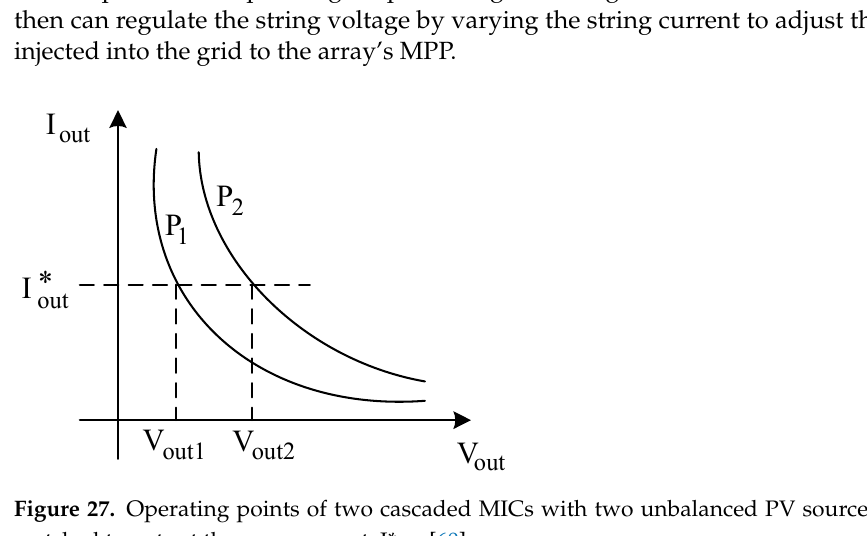
Figure 27. Operating points of two cascaded MICs with two unbalanced PV sources, P 1 and P 2 , matched to output the same current, I* out [60].